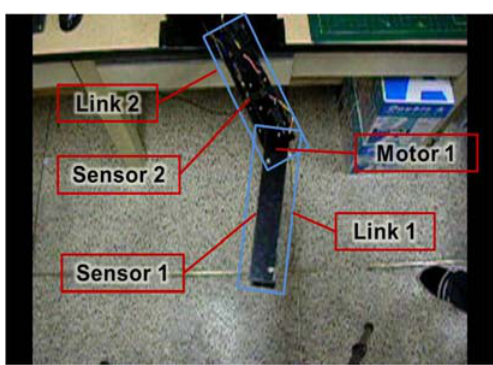
Figure 8. Two-link manipulator.